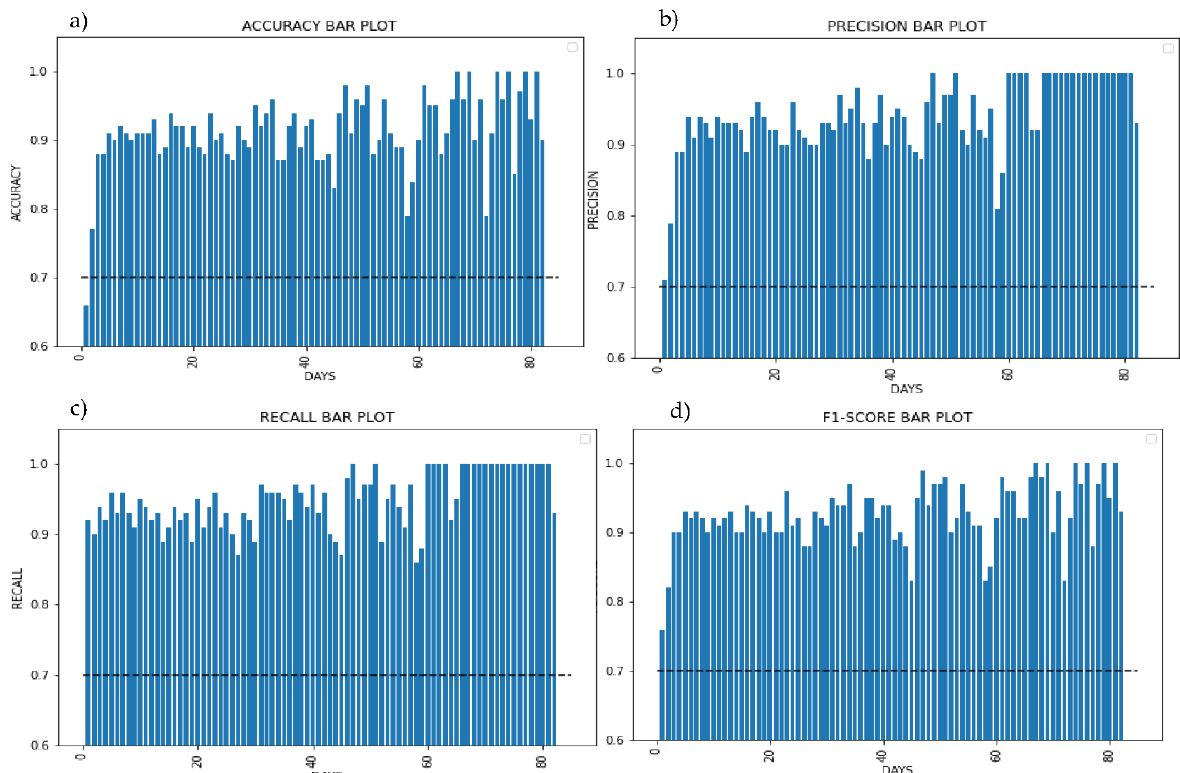
Figure 9. ( a ). Accuracy of the Model on Different Days ( b ). Precision of the Model on Different Days ( c ). Recall of the Model on Different Days ( d ). F1-score of the Model on Different Days .